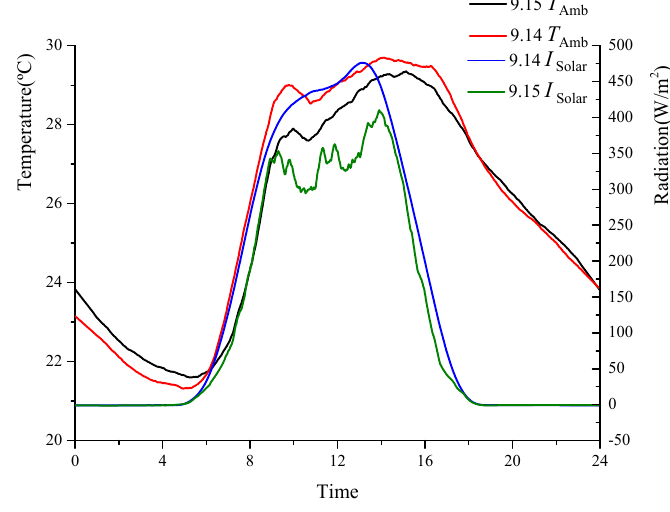
Figure 4. Ambient parameter comparison between 14 and 15 September (insulation wall test system).